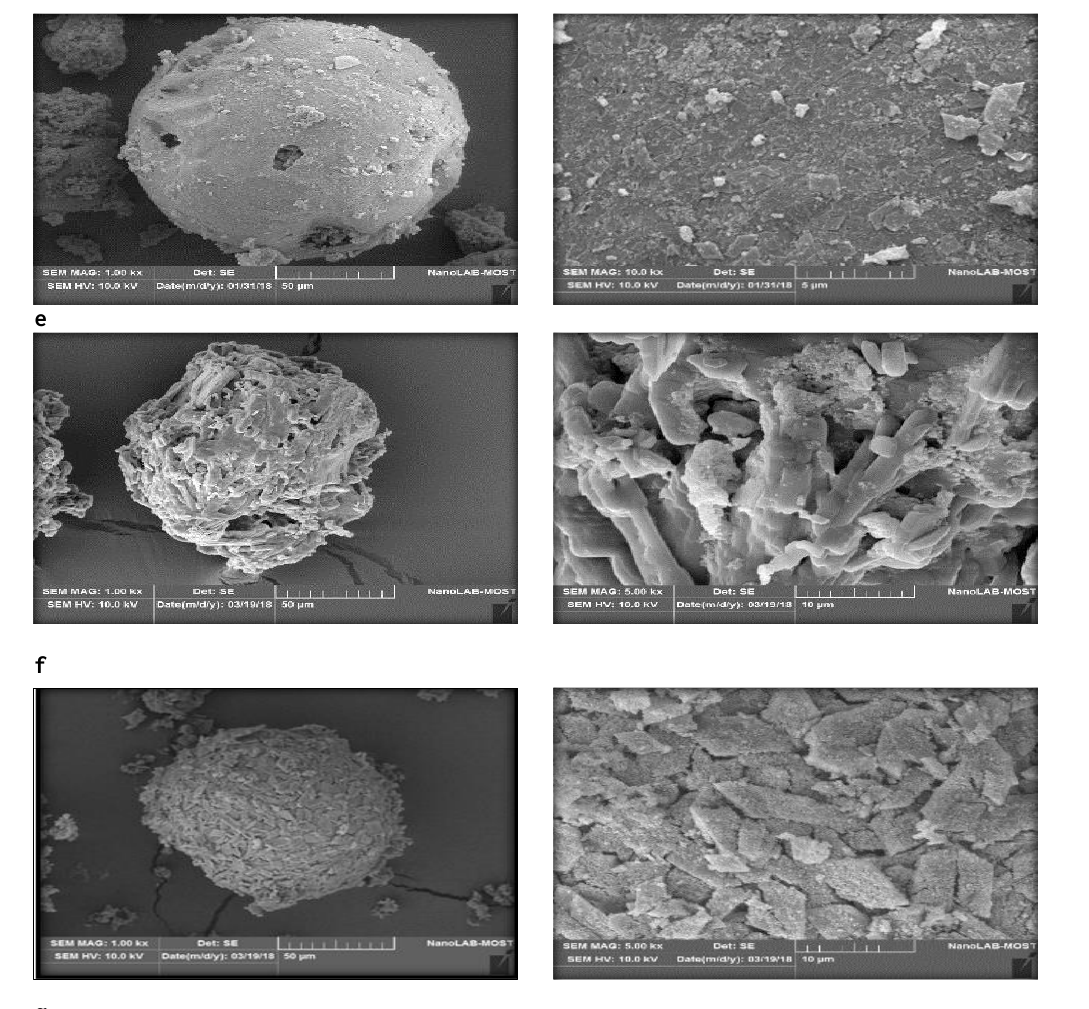
Figure 2. Scanning electron microscope of pure drug and formulated SCAs (a)pure drug, (b)EBS1, (c)EBS2, (d)EBS3, (e)EBS4, (f)EBS5, (g)EBS6under 1KX and 10KX